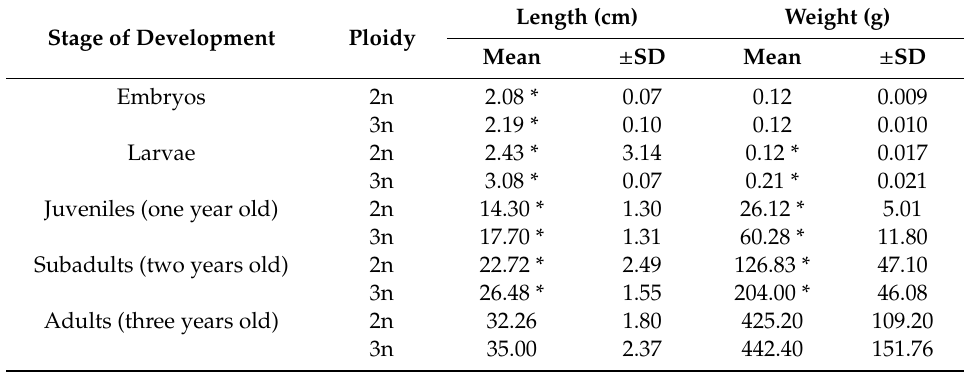
Table 1. Parameters of rainbow trout body weight and length. (*) indicate statistically significant di ff erence between diploid and triploid fish at the same stage of development. Stage of Development